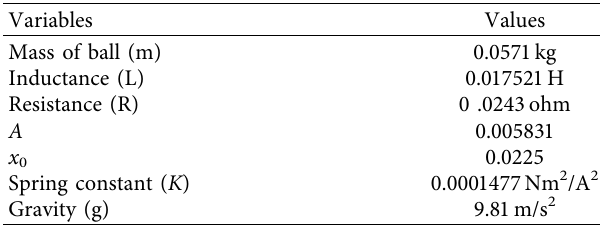
Table 1: The parameter value of the Maglev system.